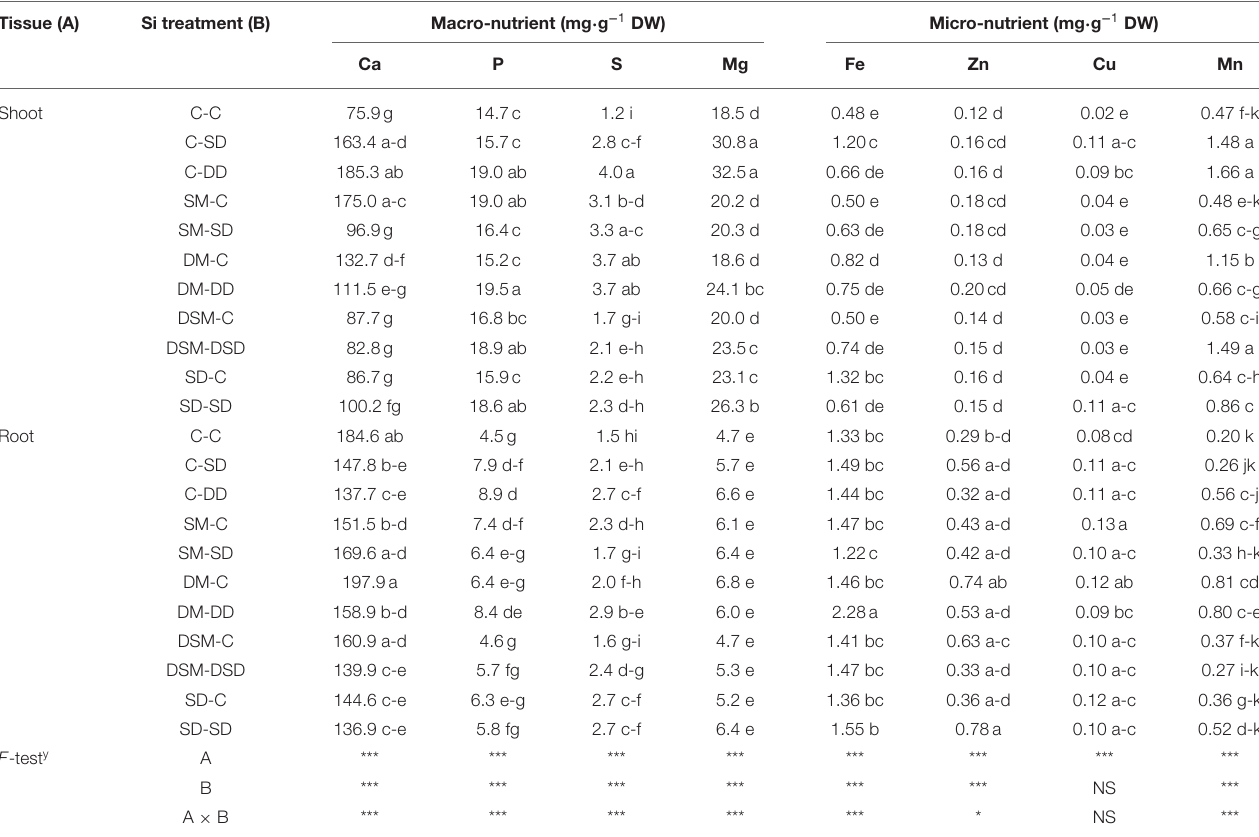
TABLE 4 | Mineral contents in leaves and root of “Maehyang” transplants as affected by different Si treatments. Tissue (A) Si treatment